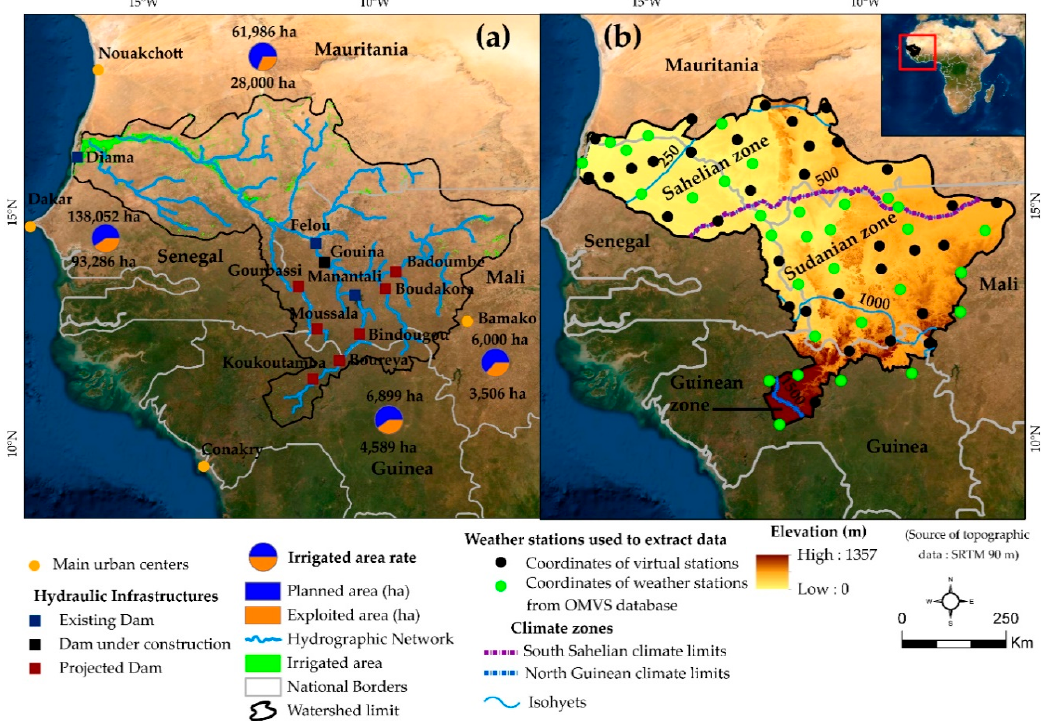
Figure 1. Senegal river basin: ( a ) main urban centers in the basin, hydraulic infrastructures and irrigated areas ( b ) stations used for the extraction of climatic variables and their altitude and limits of climatic zones.